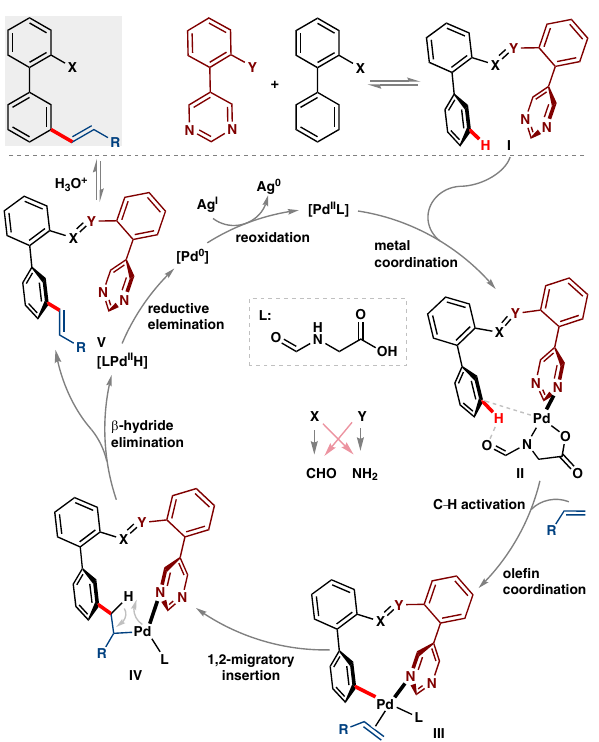
Fig. 7 Plausible catalytic cycle for meta -C – H ole fi nation. Reversible imine formation then involvement of palladium and ole fi n in catalytic cycle has been